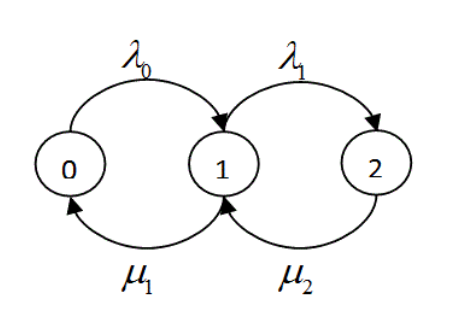
Figure 2. M/M/1/2 Markov Chain.